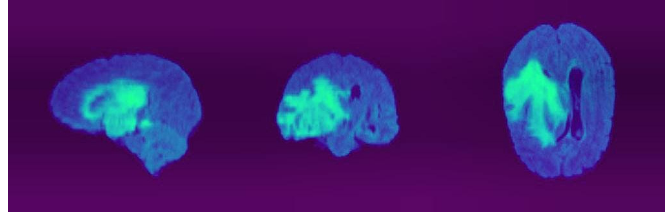
Figure 4. Architecture of attention module.